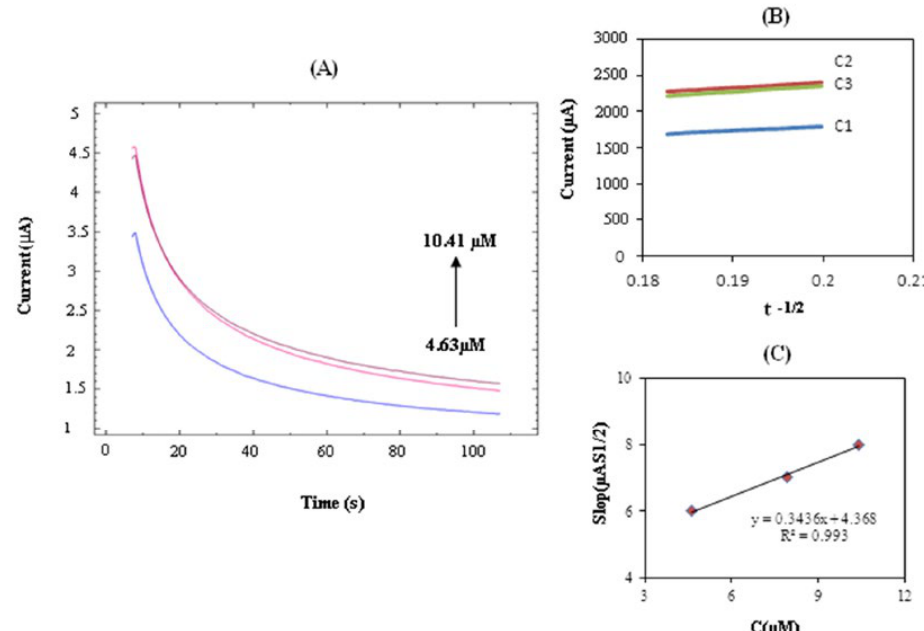
Fig. 9. (A) Chronoamperograms obtained at Ppy-GF/PGE in the presence of (C1) 4.63µM, (C2) 7.94µM, (C3) 10.41µM,insulin; 0.1 M Na 2 SO 4 supporting electrolyte; (B and C) the calibration